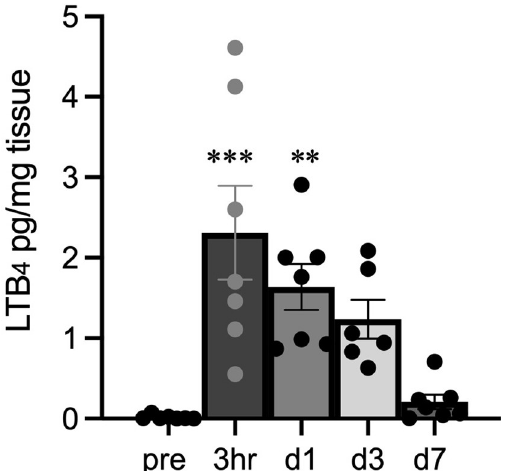
Infiltrated neutrophils peaked 1day after the incision, and there was no significant difference between BLT1WT and BLT1KO mice (Fig 3C). Infiltrated Ly6C high monocytes increased 1–3 days after the incision (Fig 3D). The accumulation of Ly6C high monocytes was significantly more attenuated in BLT1KO mice than in BLT1WT mice on post-incisional days 1 (p < 0.05) and day3 (p < 0.01). Ly6C low monocytes increased from day 3 and remained high until day 7 after the inci- sion, but their levels did not differ significantly between BLT1WT and BLT1KO mice (Fig 3E).